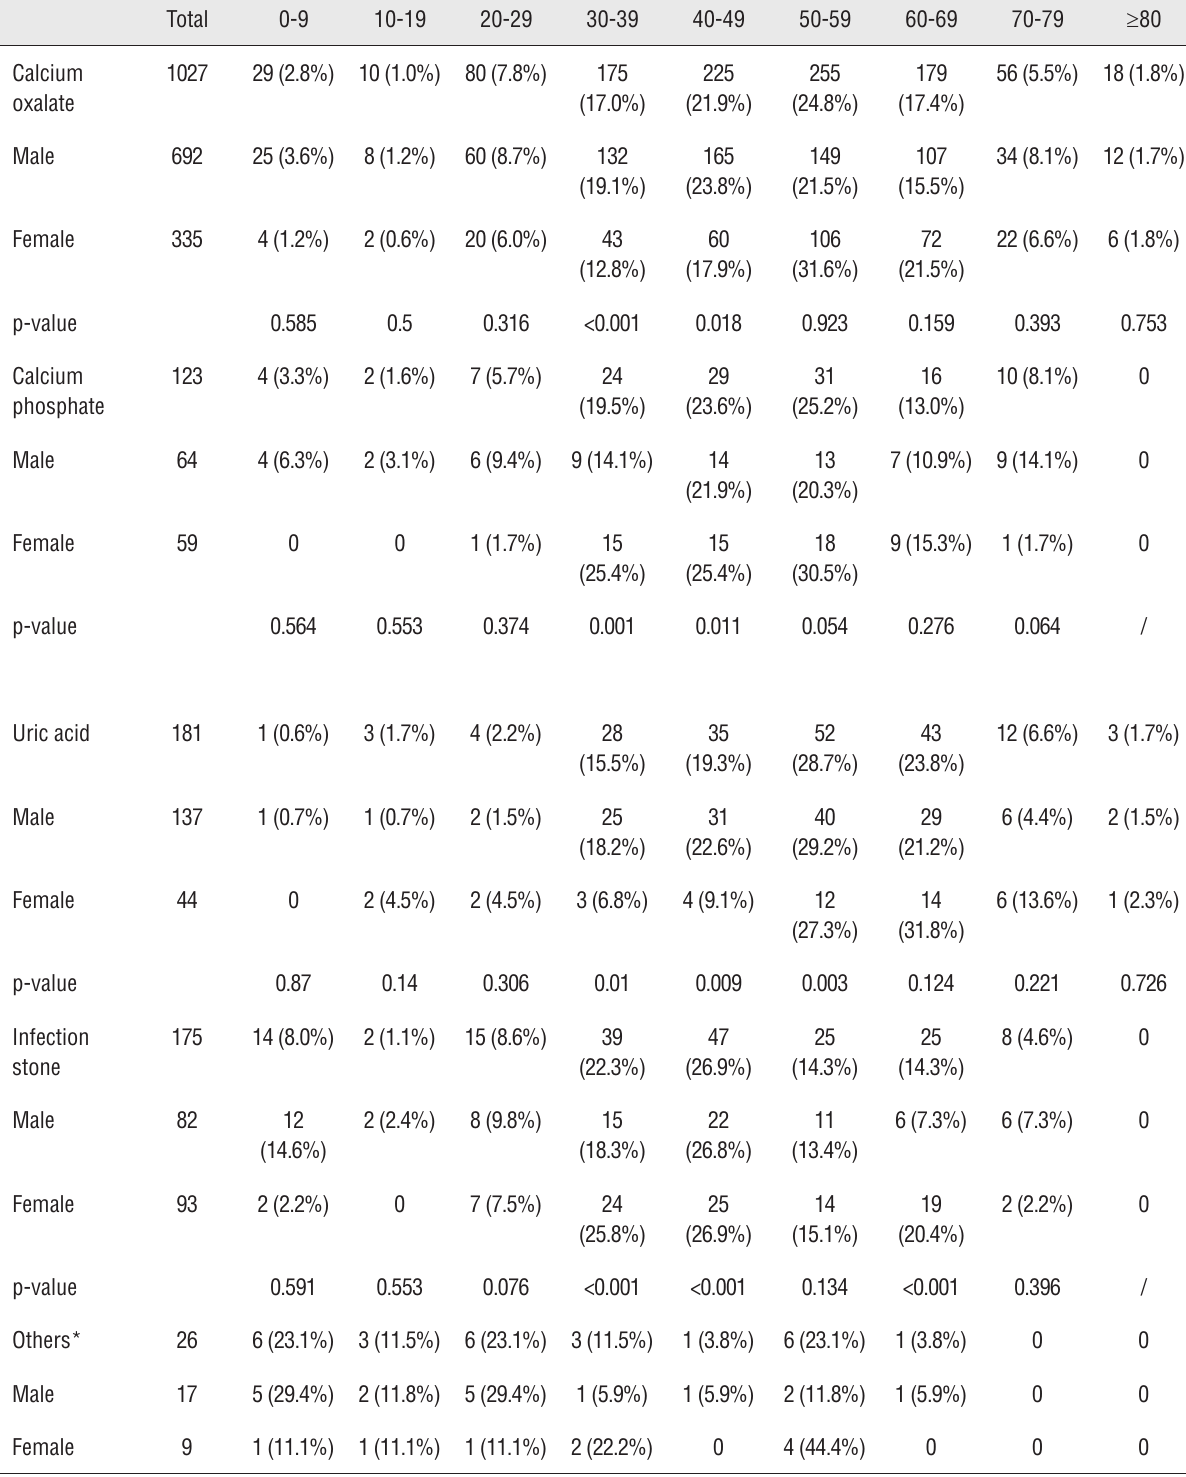
Table 3 - Proportions of different stone compositions stratified by age